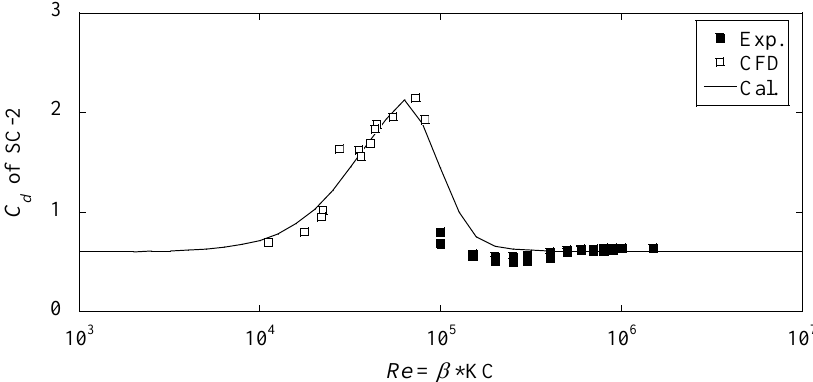
Figure 3. Variation of C d of SC-2 with Reynolds number in the oscillatory flow. Table 2. List of correction factors for each component.